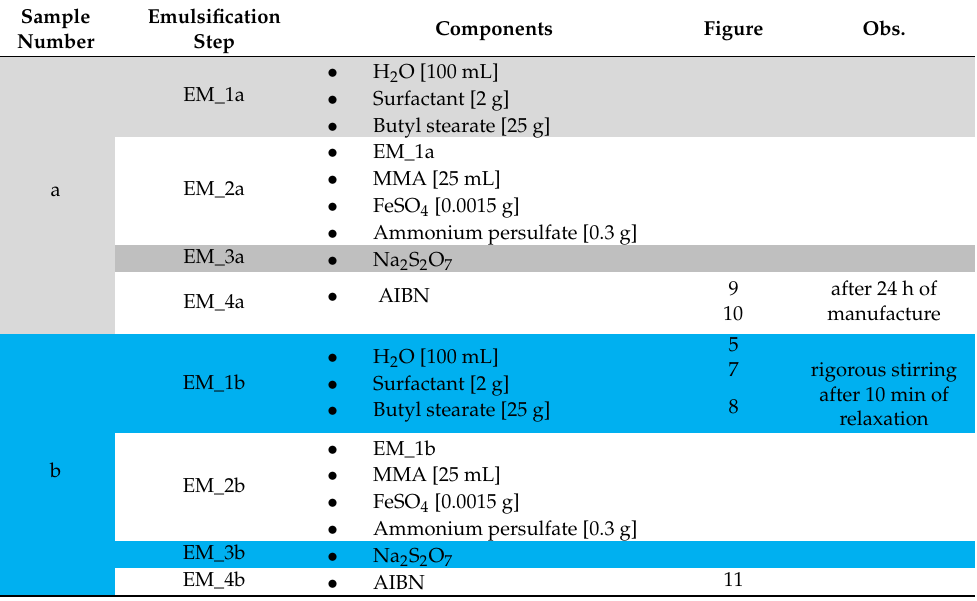
Table 2. Sample emulsification